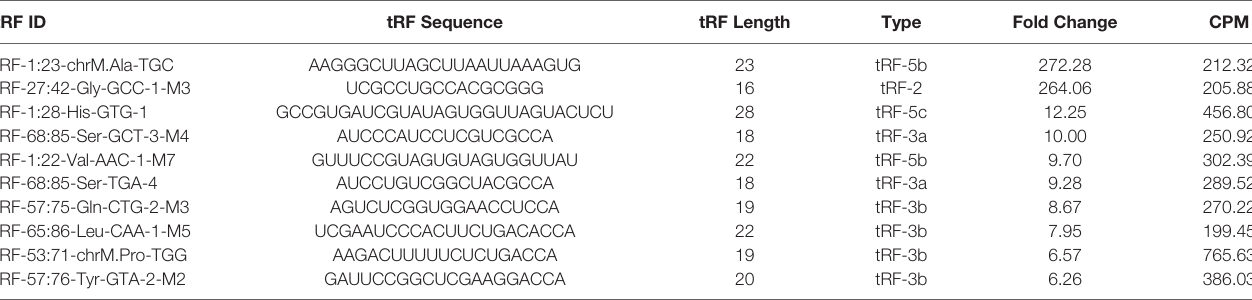
TABLE 2 | Sequencing information of 10 candidate tsRNAs.